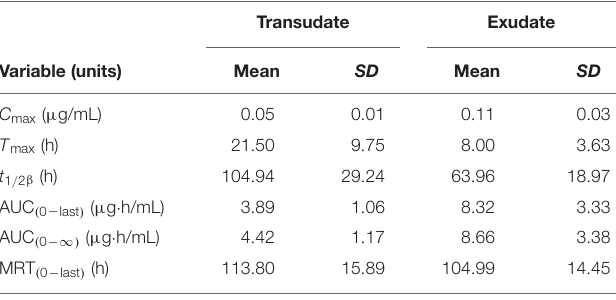
TABLE 1 | The pharmacokinetic parameters (non-compartmental analysis) of tulathromycin in serum after i.v. or i.m. administration at a dosage of 2.5 mg/kg (mean ± SD, n = 6).